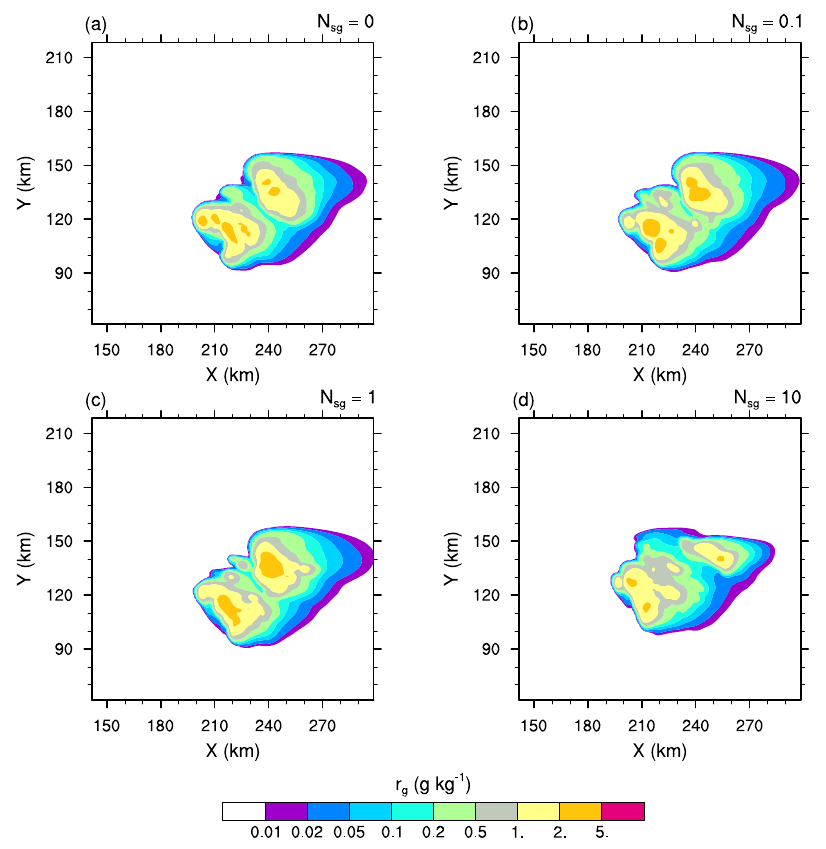
Figure 5. As in Fig. 3 but for the mixing ratios of graupel ( r g ). Table 2. After 3h of simulation, maximum value of the cloud ice number concentration N i produced per snow-aggregate–graupel collision N sg . The last row shows the CIBU enhancement factor CIBU ef in percent (see text). N sg (no